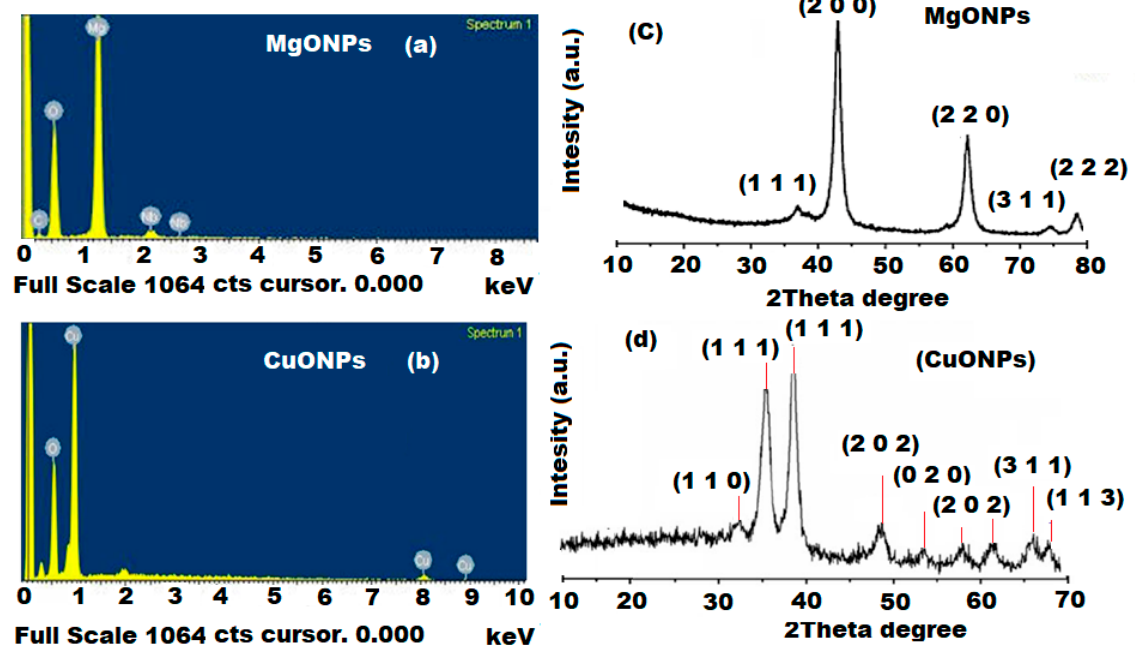
Figure 4. ( a , b ) EDX and ( c , d ) XRD spectra of MgONPs and CuONPs using XRD diffractometer with Cu-k α at (k = 1.5405 A°).